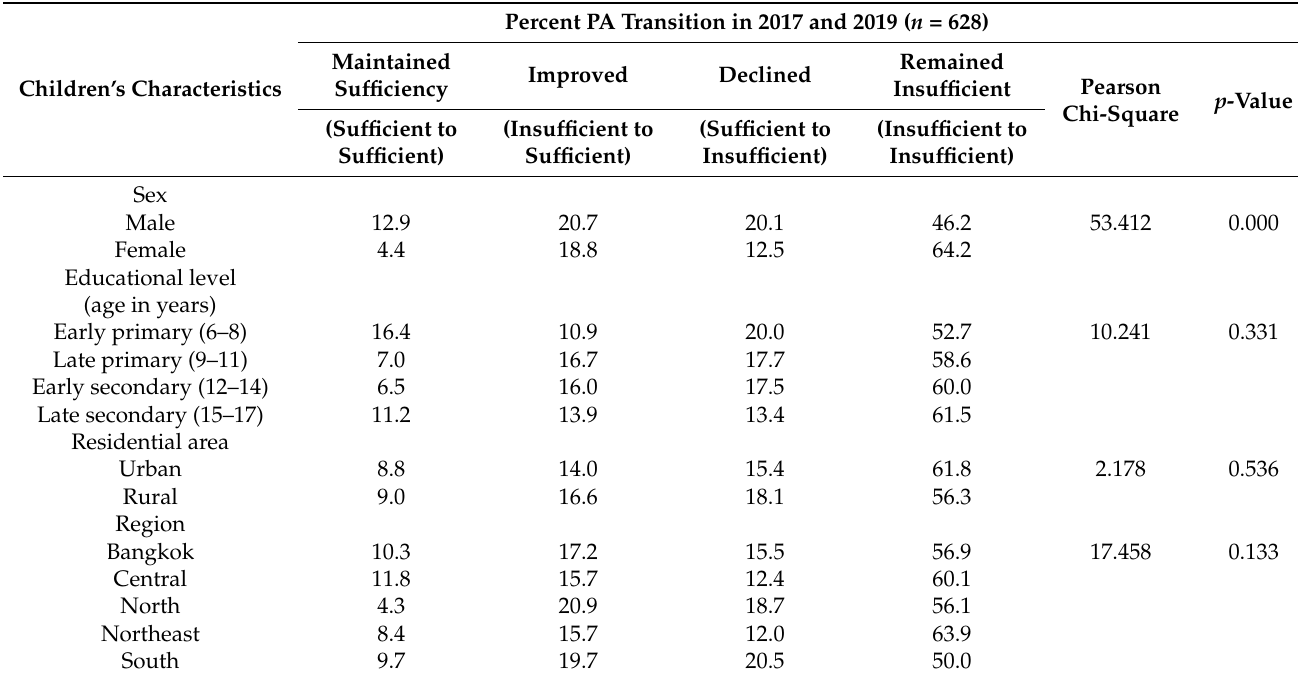
Table 3. Physical activity transition among Thai children and young people 2017–2019.